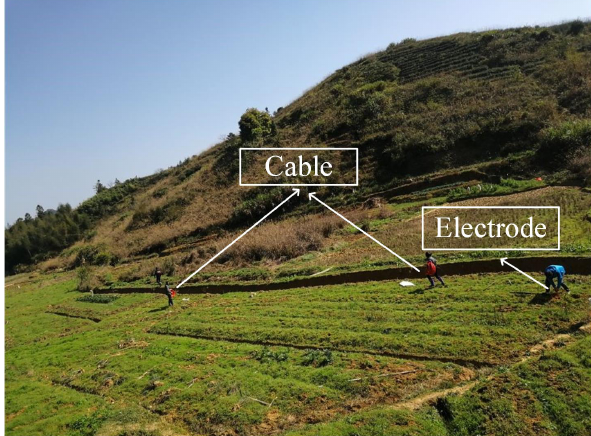
Figure 14. Photo of the field